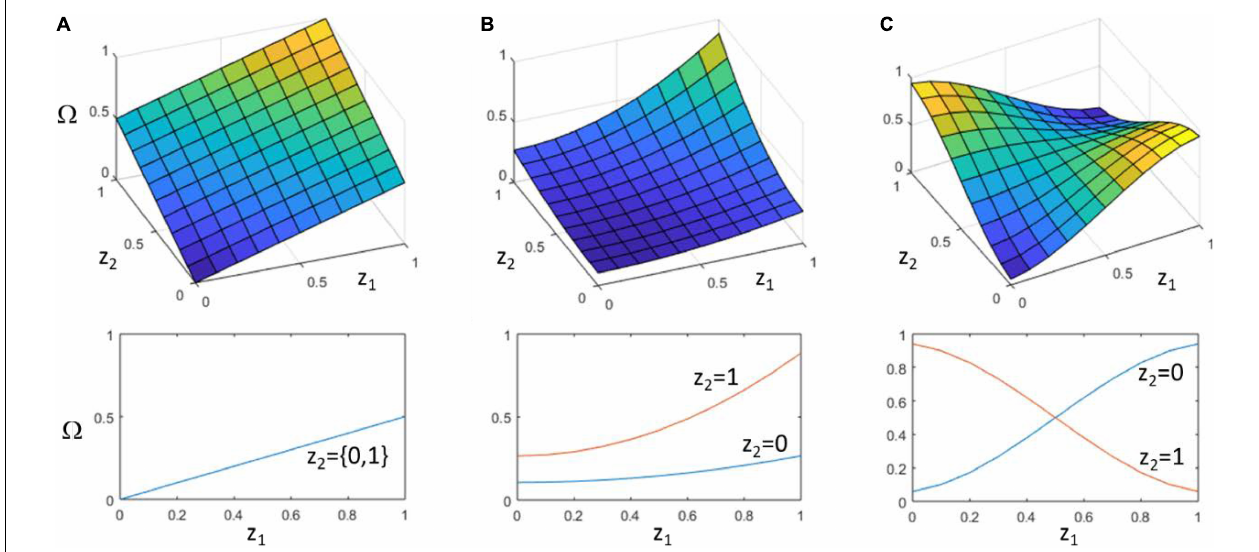
FIGURE 1 | Different possibilities for the relationship of particle characters to collective character. (A) Additive (no interaction). Two particles, with characters z 1 and z 2 , each contribute to collective character, (cid:127) , independently. That is, changes in z 1 always have the same effect on (cid:127) regardless of the value of z 2 and vice versa. (B) Synergistic interaction . The effect of z 1 on (cid:127) increases with the value of z 2 . The two together thus have a synergistic, i.e., super-additive, effect on collective character. (C) Non-decomposable interaction . The sign of the effect of z 1 on (cid:127) can be reversed by the context of z 2 . The class of particle character configurations that confer high values of (cid:127) (yellow) is defined by a non-linearly separable function over z 1 and z 2 , such as z 1 XOR z 2 ( Box 1 ) (this is not the case in (B) which remains linearly separable, i.e., z 1 AND z 2 ). The lower panels show the value of (cid:127) as a function of z 1 . (A) insensitive to z 2 , (B) slope of response depends on value of z 2 but does not change sign, (C) sign of response depends on value of z 2 . Note that in both (B,C) , (cid:127) is a non-aggregative function of the particle characters, but only (C) is non-decomposable in the sense of being non-linearly